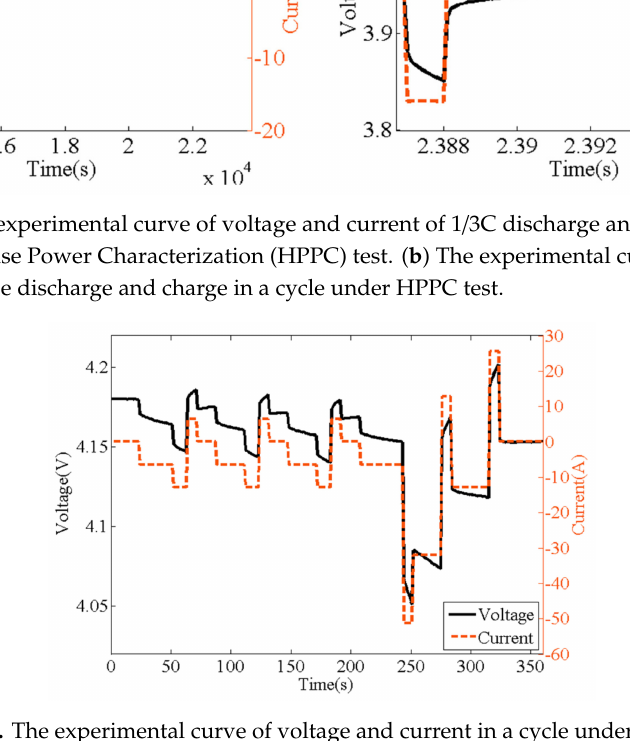
Figure 7. The experimental curve of voltage and current in a cycle under DST